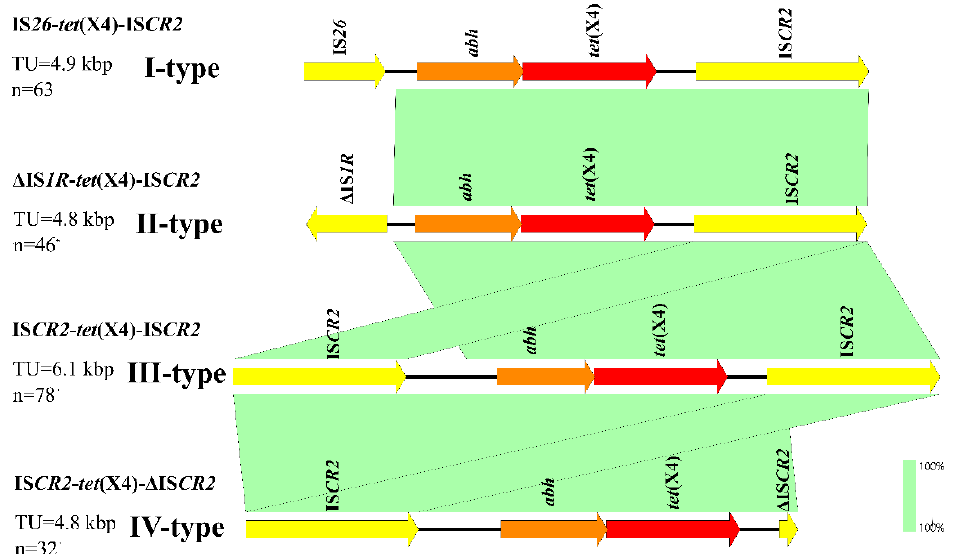
Figure 6. Genetic environment of tet (X4) in E. coli . Areas shaded in light green indicate homologies between the corresponding genetic loci.